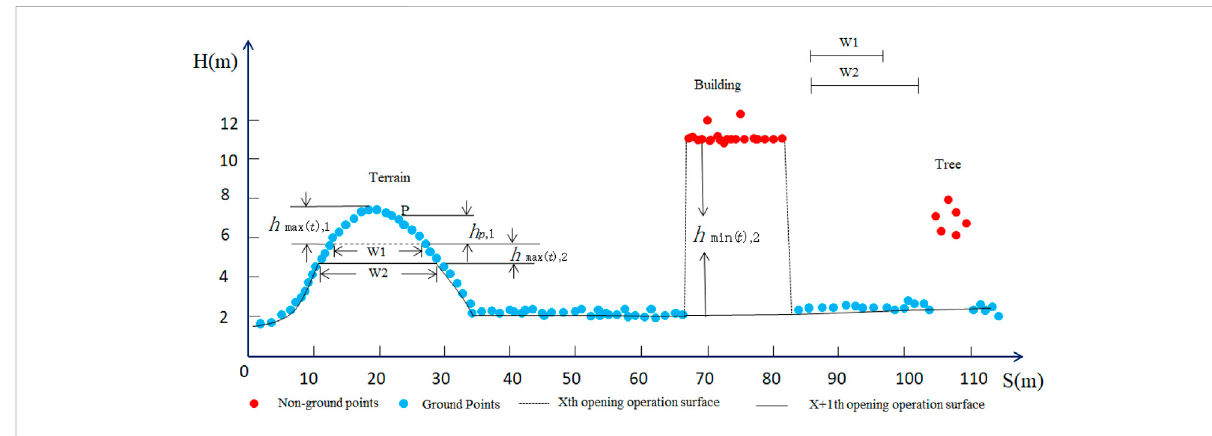
FIGURE 5 Schematic diagram of the progressive morphological fi lter.